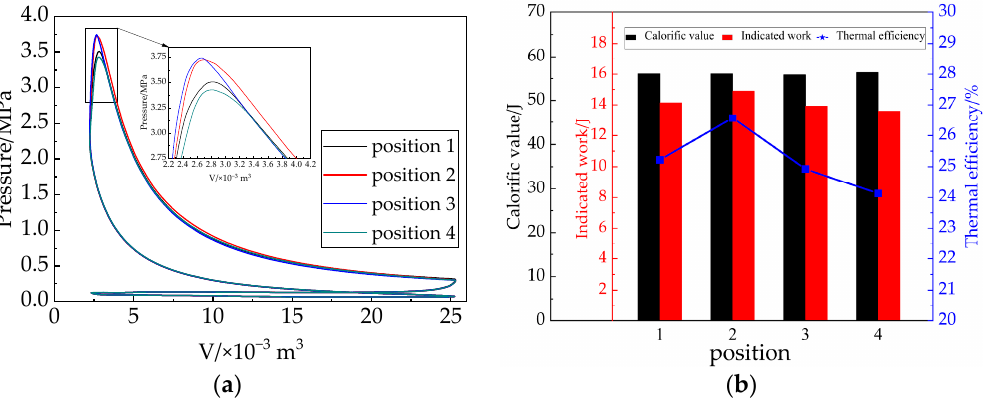
Figure 12. Comparison of overall engine performance at different positions: ( a ) P-V diagram, ( b ) indicated thermal efficiency.